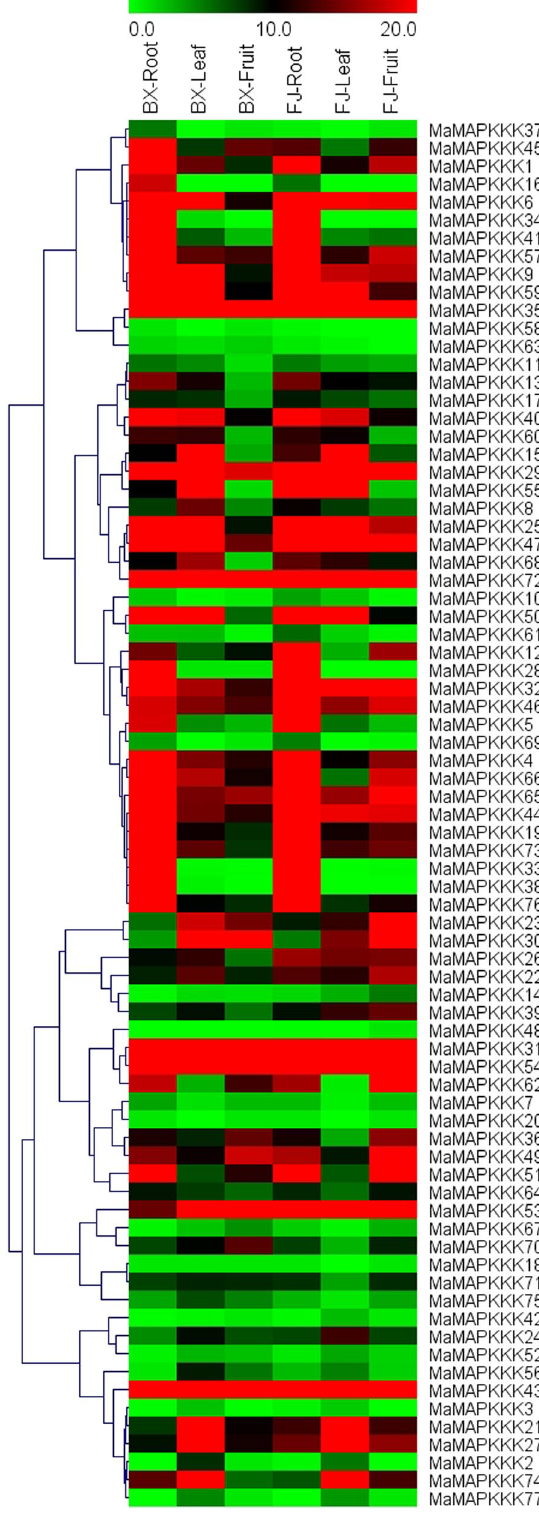
Figure 6. Expression profiles of banana MAPKKKs in roots, leaves and fruits of BX and FJ. The heat map was constructed according to the FPKM value of banana RNA-seq data. Changes in gene expression are shown in color as the